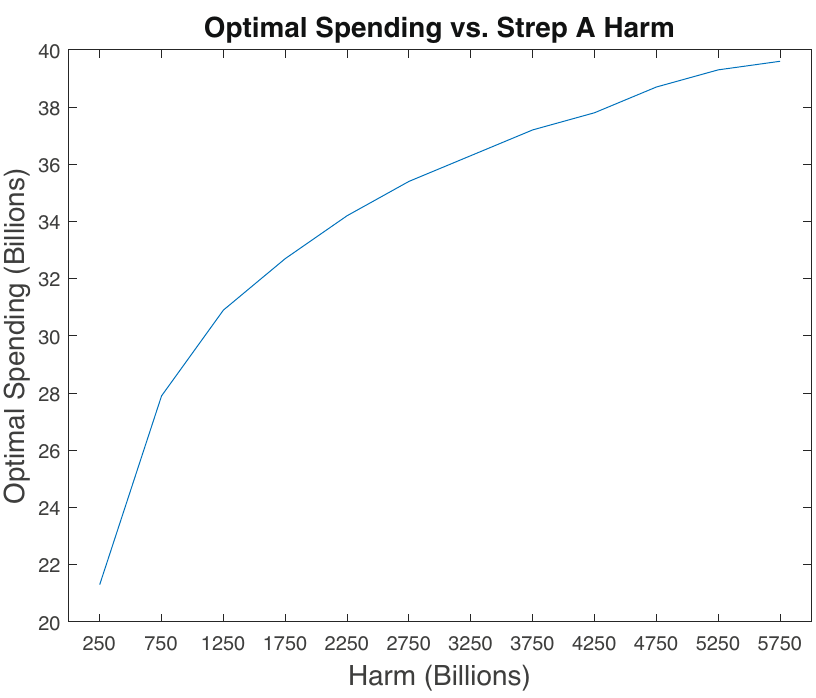
Fig. 2 Optimal spending vs. Strep A harm. Monetary values are in 2020